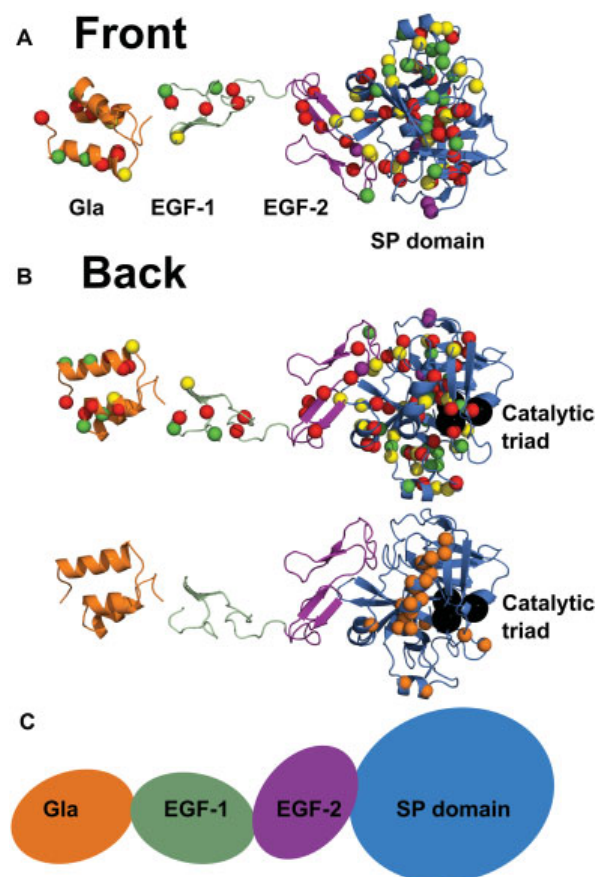
Fig. 6 Structural view of the distribution of variants within FXa. ( A and B ) illustrate the front and back views (rotated by 180°) of the distribution of 113 missense variants and 4 polymorphisms within mature factor X (FX). The merged FXa crystal structure is shown in ribbon format, with the C α positions of the variants and polymorphisms highlighted as spheres. The variant locations are colored according to their phenotype. Type-I (CRM (cid:2) ) variants are in red, type-II (CRM þ ) variants in green, and those with unknown phenotype in yellow. The nondisease associated polymorphisms are depicted in purple. The catalytic triad His276-Asp322-Ser419 (HGVS numbering) is shown in ( B ) in the SP domain as black spheres. In ( B ) also, orange spheres denotethe residues Arg313, Lys316, Arg346, Arg 387, Lys391, Lys460, and Arg469 (HGVS numbering) correspond to a heparin binding site in FX (chymotrypsin numbering Arg93, Lys96, Arg125, Arg165, Lys169, Lys236, and Arg240). These heparin binding residues together with Asp413-Asp418 and Val455-Arg469 (HGVS numbering) are involved with Factor Va binding (chymotrypsin numbering Asp185-Asp189 and Val231-Arg245). The ribbon colors correspond to those used on our web site https://www.factorx-db.org . EGF, epidermal growth factor; GLA, γ -carboxyglutamic acid; SP, serine protease.( C ) Schematic representation of the four domains in FX. The four domains are aligned and depicted in the same orientation and colors as in the ribbons in ( A and B )